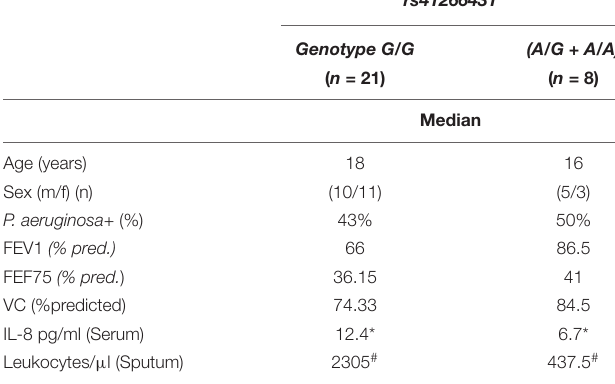
TABLE 5 | Functional data by